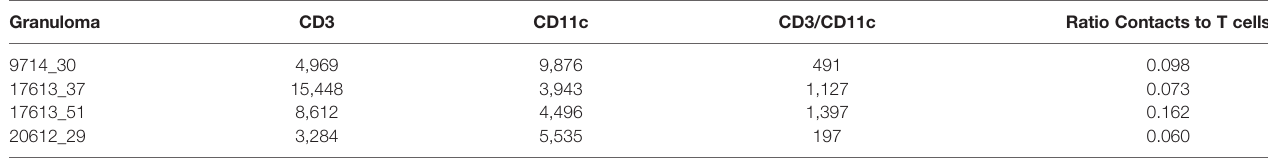
TABLE 2 | Geographical Information Systems Technology (GIS) analysis identi fi es numbers of cells of two types, and numbers of contacts from four immunohistochemistry (IHC) granulomas. Granuloma